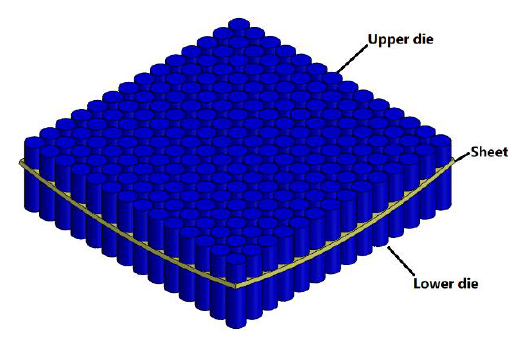
Figure 1. Multipoint-forming principle.